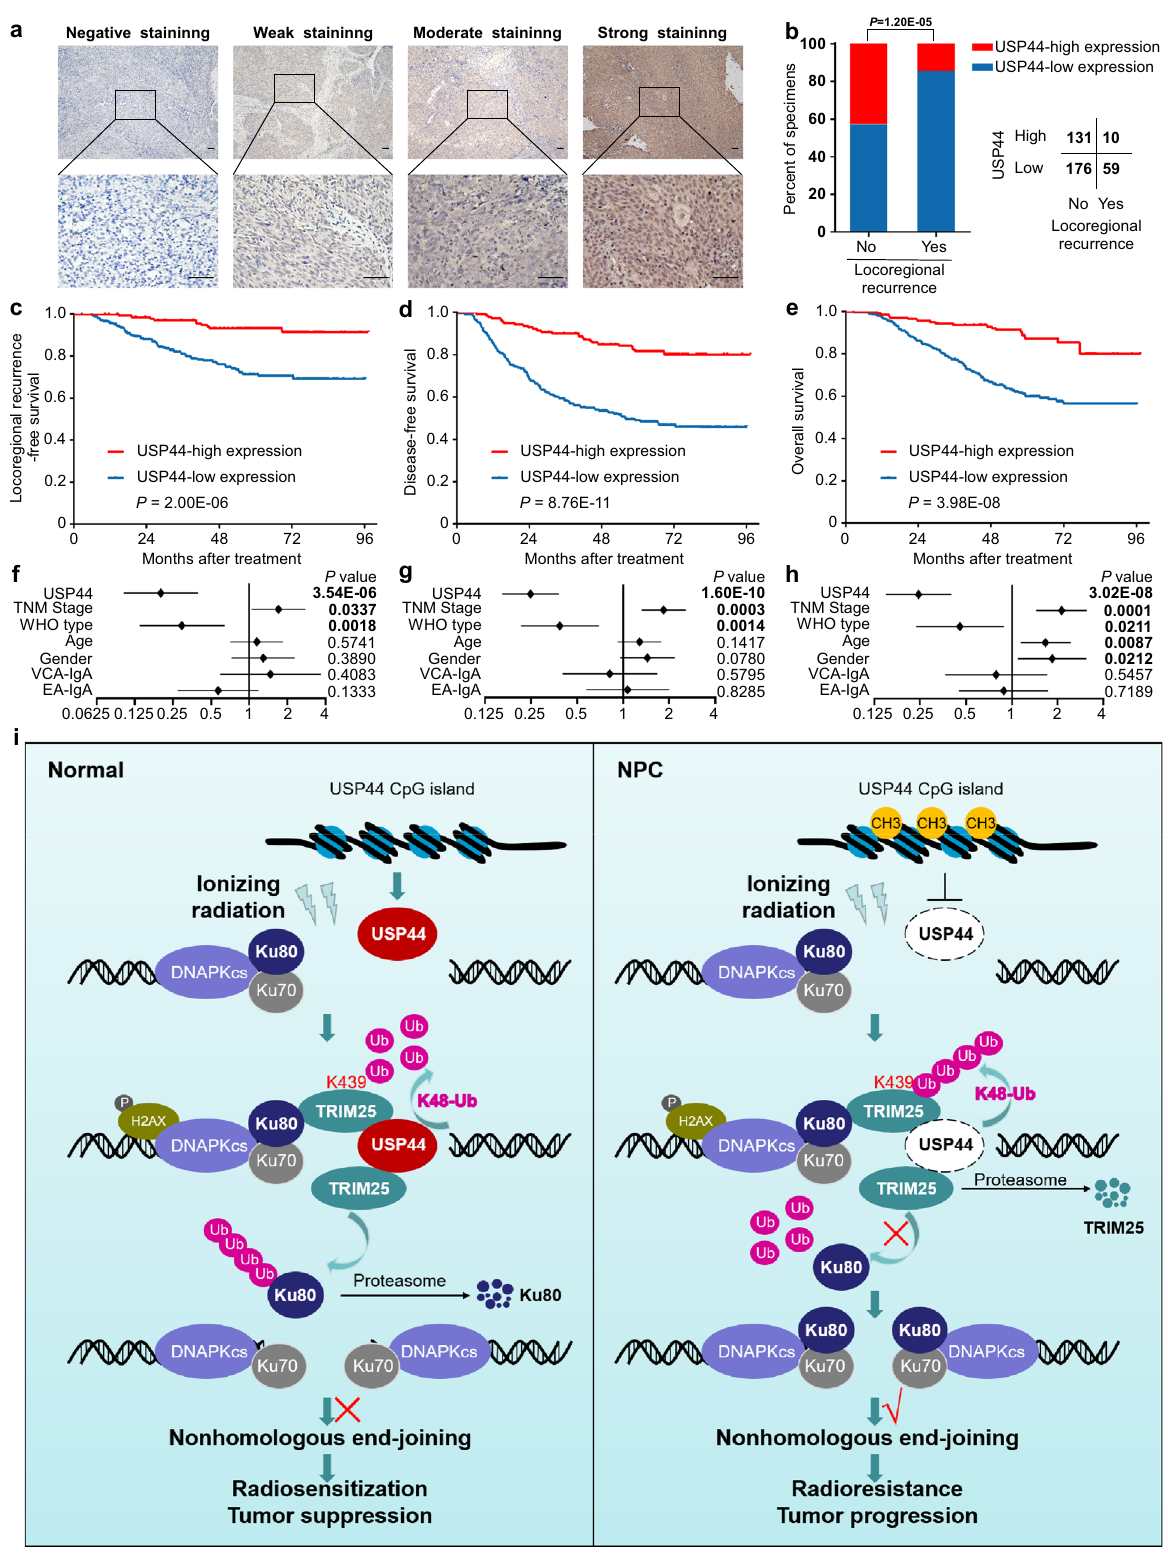
independent prognostic factors. The strength of the relationship is evaluated using the Spearman correlation. Unless otherwise indicated, the experiments were performed independently in triplicate, and n is indicated in the fi gure